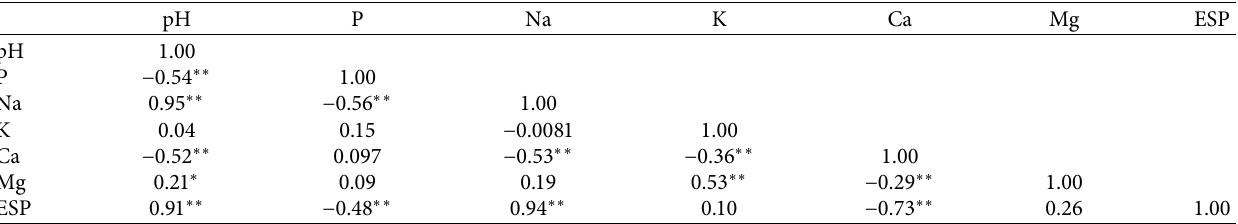
Table 3: Correlation coefficients ( r ) among different soil parameters during incubation.